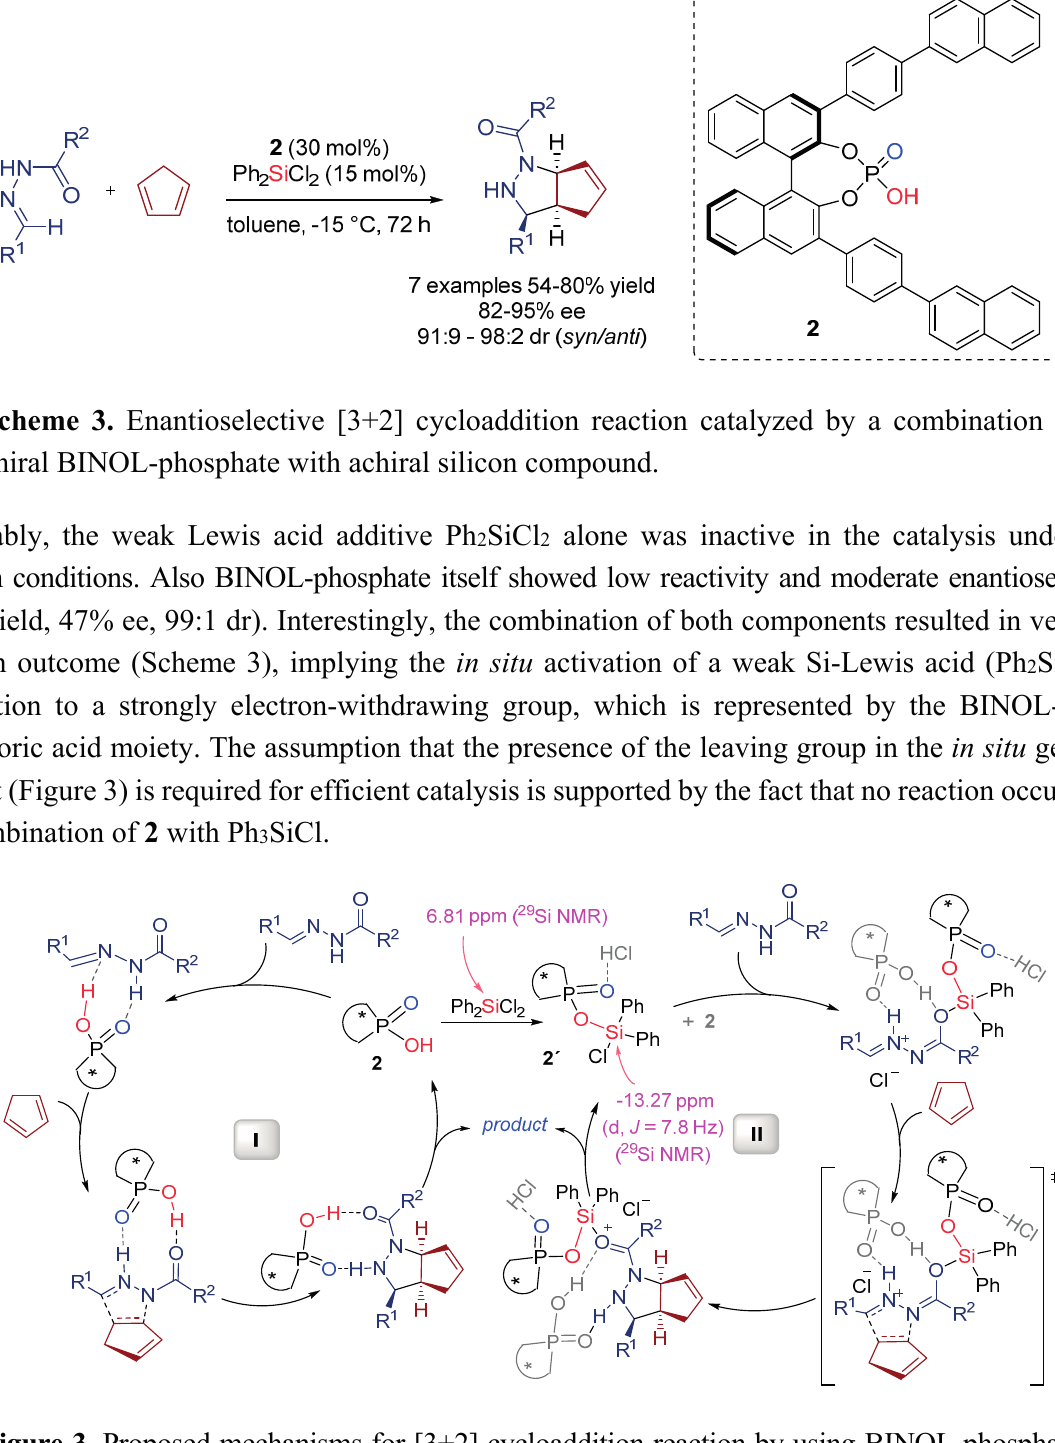
Figure 3. Proposed mechanisms for [3+2] cycloaddition reaction by using BINOL-phosphate alone (I) and applying BINOL-phosphate/Ph 2 SiCl 2 (2:1) as a catalytic system